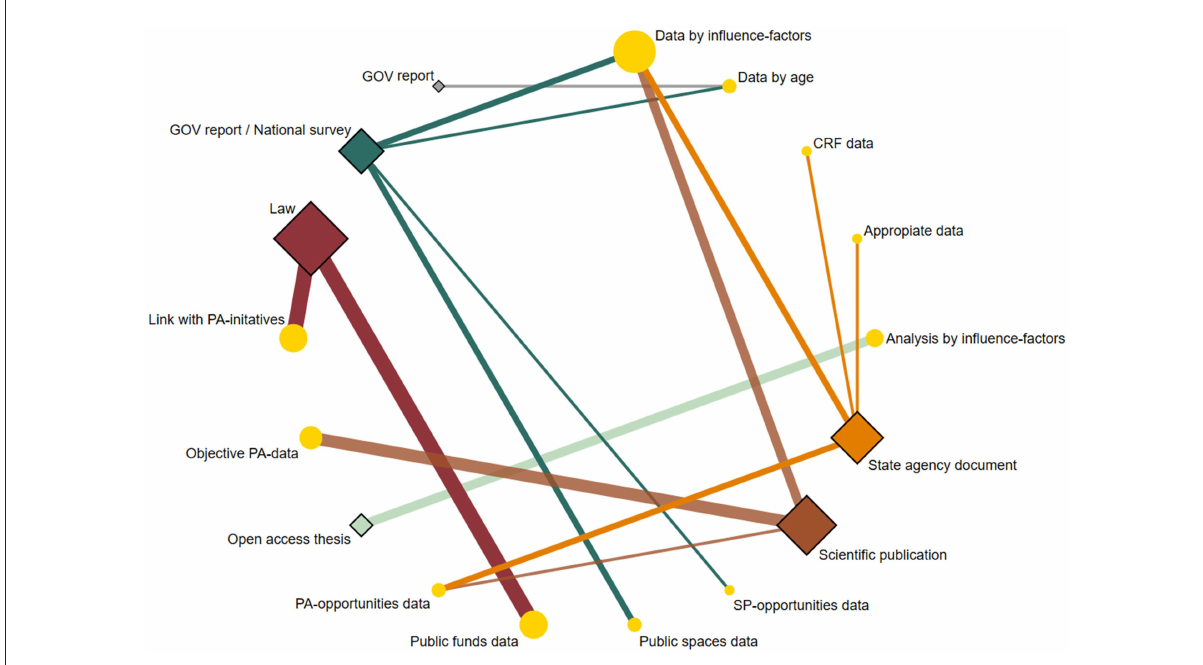
FIGURE7 Network geometry plots of available comparisons between the type of evidence and their gaps. The size of the circular nodes (research gaps) was relative to the number of papers analyzing these components. The size of the diamond nodes (type of evidence) was relative to the number of available data on research gaps analyzing these components. The width of the solid line connecting the nodes was relative to the number of papers analyzing the research gaps (circular nodes) according to the type of evidence (diamond nodes). CRF, Cardiorespiratory fitness; GOV, Government; PA, Physical activity; SP, Sport and physical activity